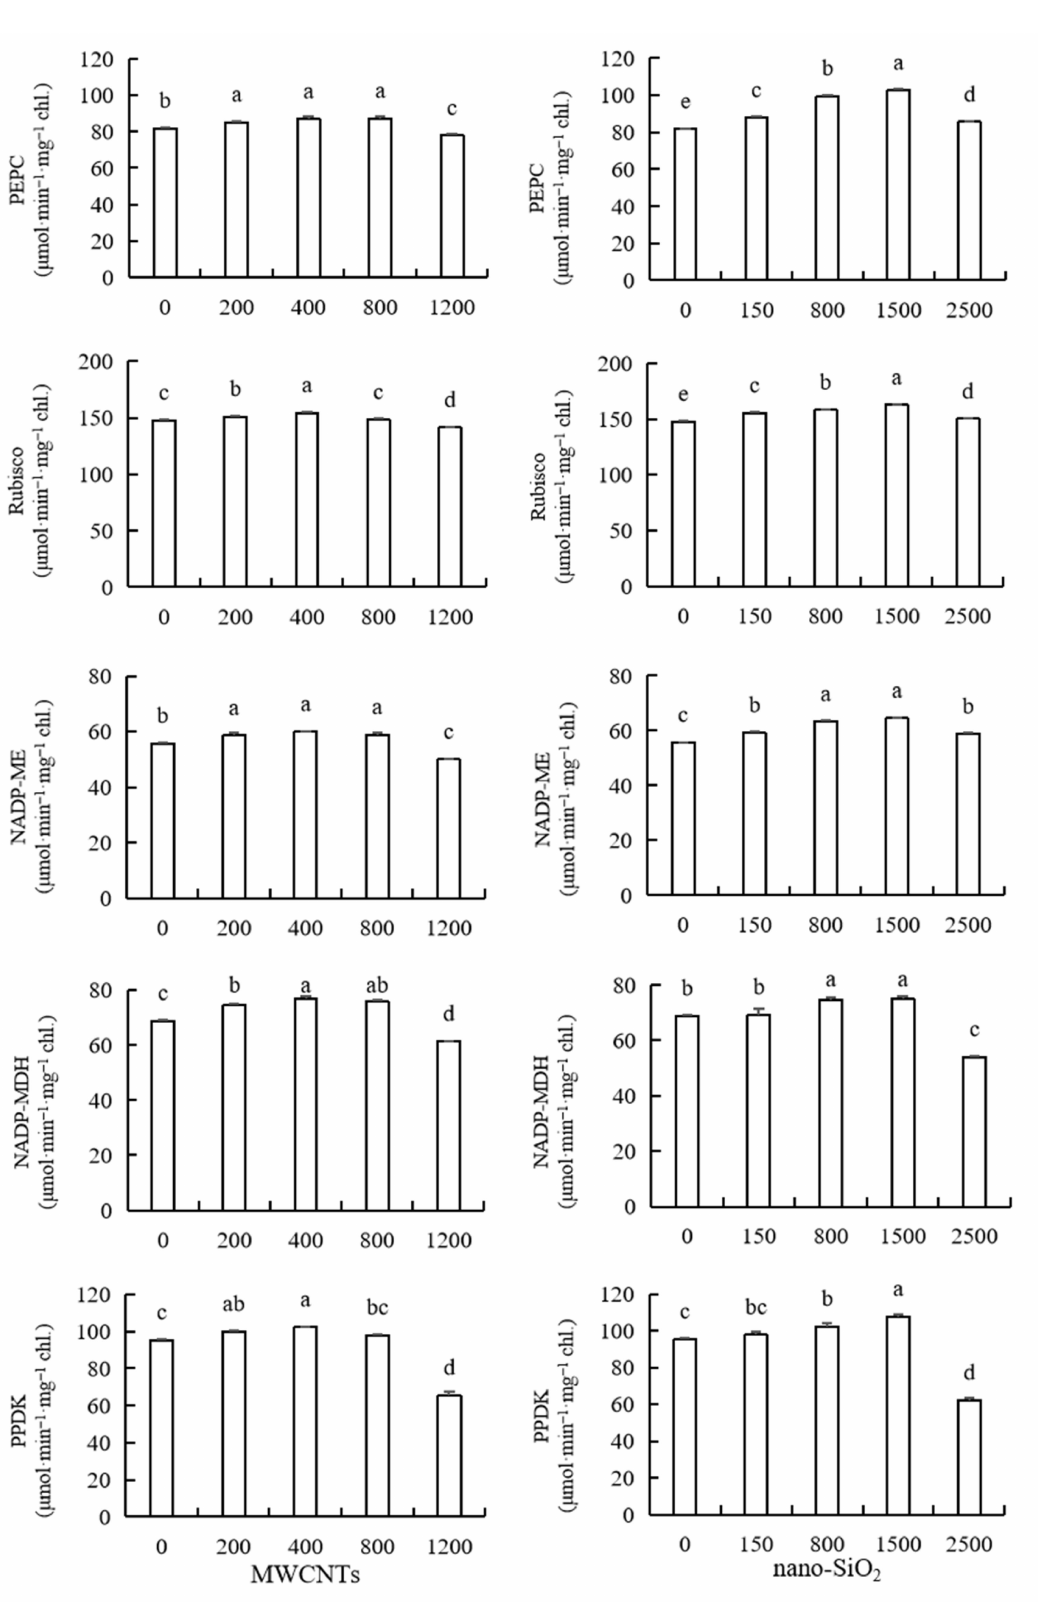
Figure 6. Effect of different concentrations of MWCNTs and nano-SiO 2 on leaf photosynthetic enzymes in maize. Note: Data are expressed as mean ± standard deviation. Different letters within the same column indicate significant difference at 5%